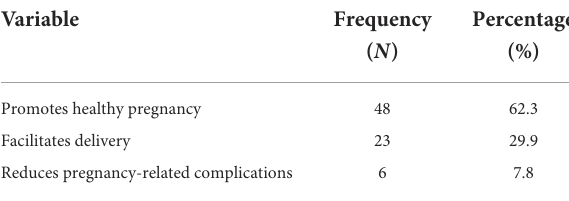
TABLE 10 Participant’s specific responses to why physical exercise during pregnancy is beneficial ( n =